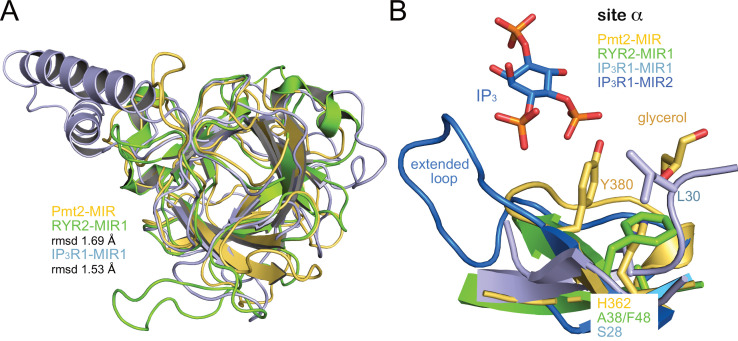
Comparison of MIR domains.(A) Superposition of MIR domains. Structures of MIR domains shown are: PMT2-MIR (yellow), human RyR2-MIR1 (green, PDB-ID 4jkq [Borko et al., 2014]) and rat IP3R1-MIR1 (blue, PDB-ID 3uj0 [Seo et al., 2012]). The superposition is viewed along the pseudo-symmetric triad and deviations (rmsd) to PMT2-MIR are indicated. (B) Superposition of respective site α regions of different MIR domains. For Pmt2-MIR the crystal structure with bound glycerol is given. Sites α in MIR1 domains of RYR2 and IP3R1 are blocked by indicated residues. Of note, an IP3-ligand of IP3R1 binds to an extended loop next to site α of a second MIR domain MIR2.